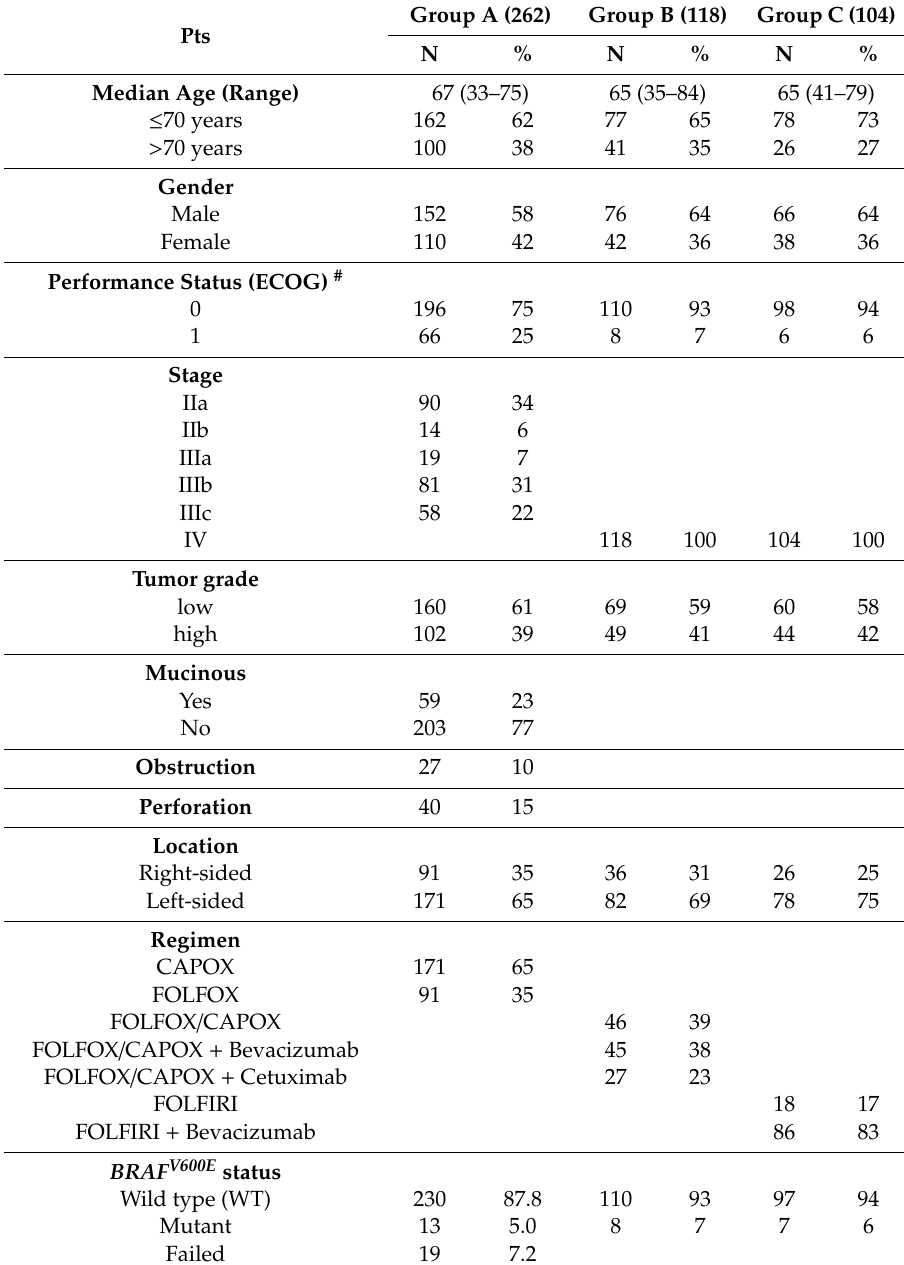
Table 1. Characteristics and pathological features of the